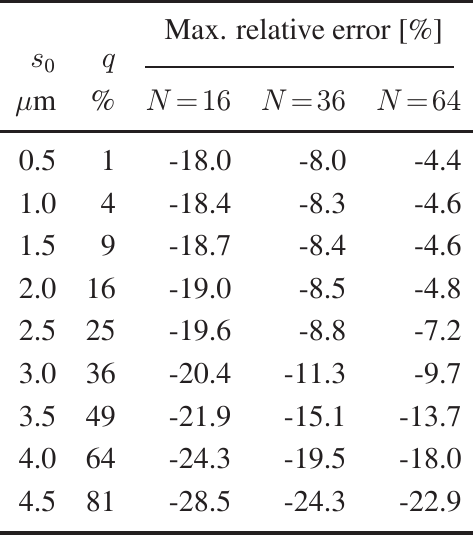
Table 3 . Maximum relative errors in the torsional motion damping coef fi cient Z method. Each row includes cases for d = 1 µ m or 2 µ m and h against the 3D simulations with the N-S